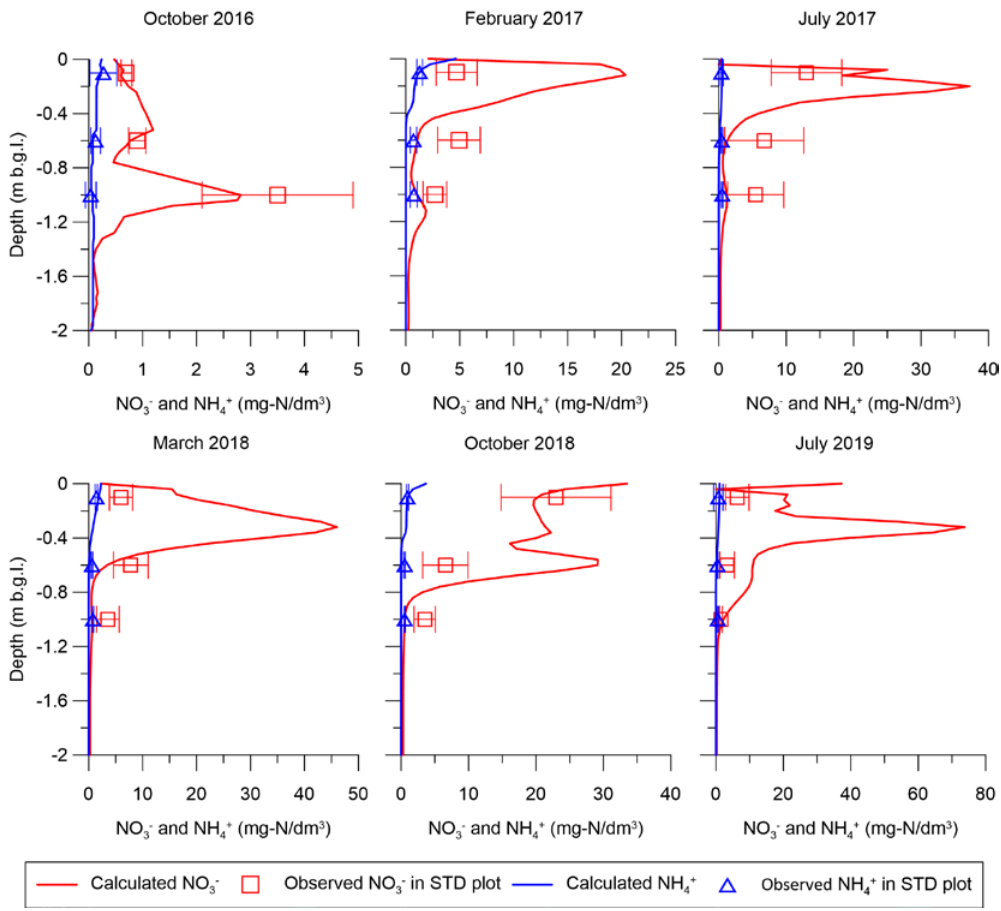
Figure 7. Comparison of the calculated (lines) and observed (open symbols) NO 3 − and NH 4+ concentrations profiles collected at selected dates in the No-till+CMP experimental plot. Error bars represent the standard deviation over 5 replicates.